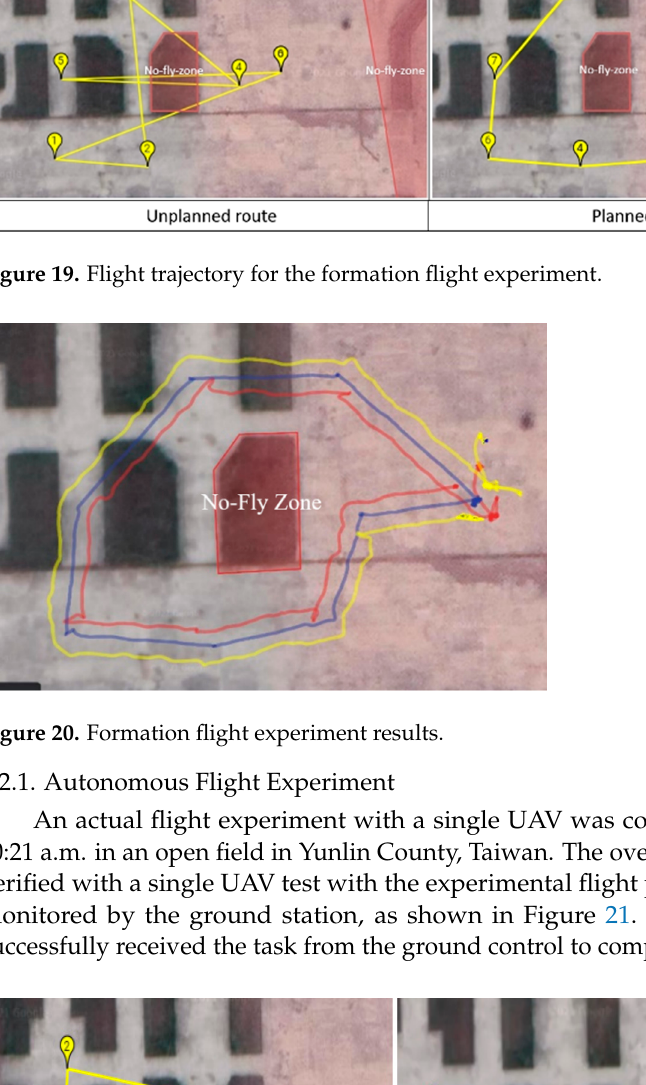
Figure 18. Formation mission simulation results.